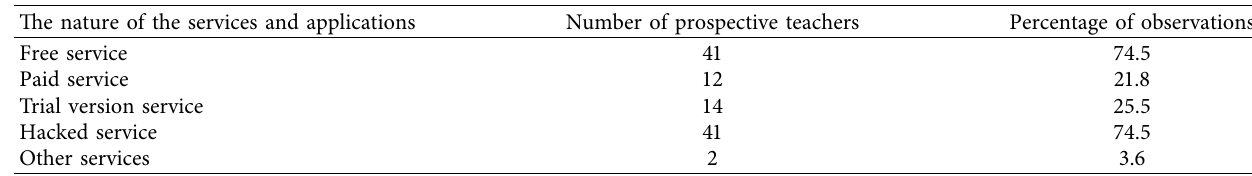
Table 8: The nature of the services that dominate the digital practices of prospective